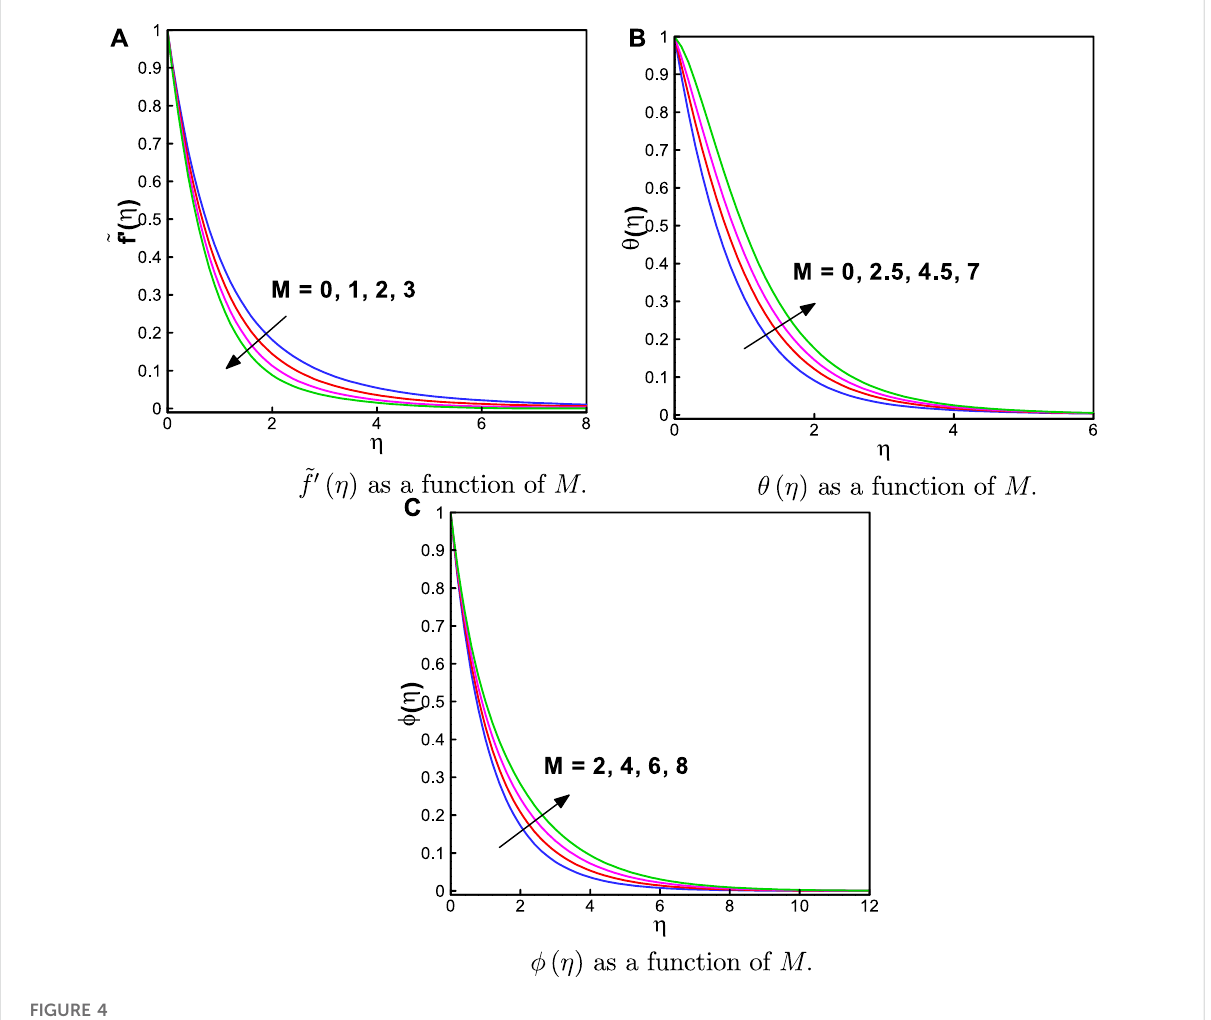
FIGURE 4 (A) ~ f ′ ( η ) as a function of M . (B) θ ( η ) as a function of M . (C) ϕ ( η ) as a function of M